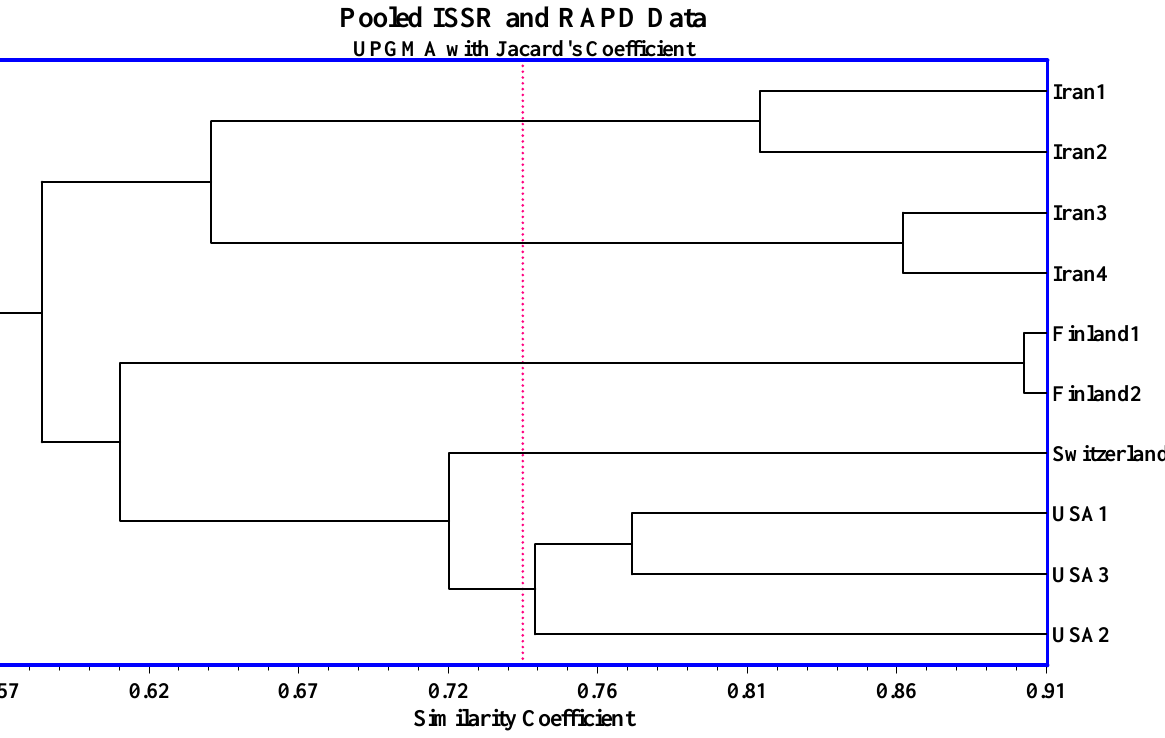
Figure 3. UPGMA Dendrogram of 10 strains of H. pluvialis based on mixed data of ISSR and RAPD